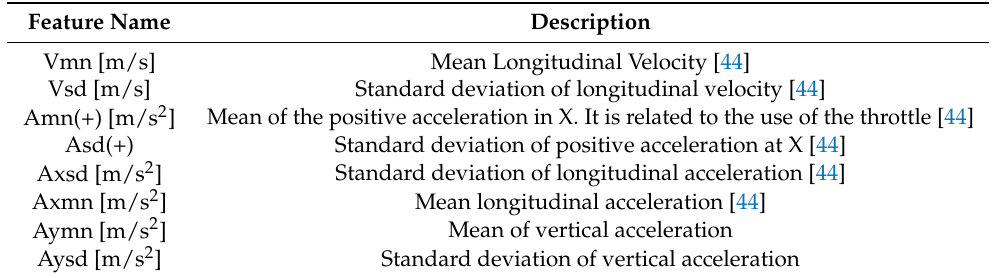
Table A2. List of